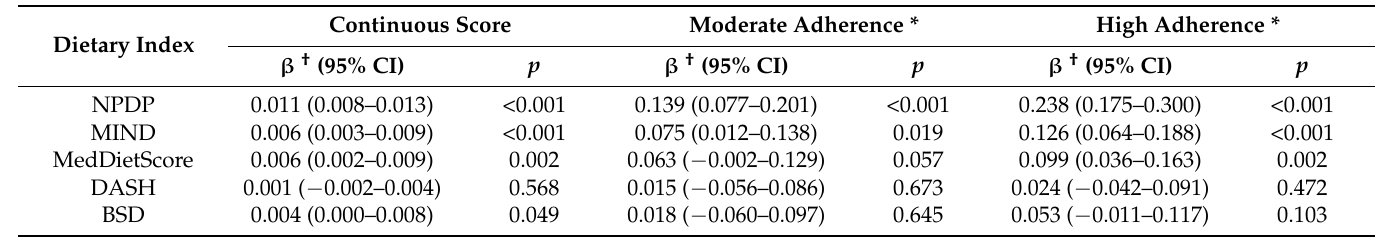
Table 3. β -coefficients (95% confidence intervals) for the association between the rate of change in MMSE score over 6 years and the Nordic Prudent Dietary Pattern (NPDP), Mediterranean-DASH Intervention for Neurodegenerative Delay (MIND), Mediterranean Diet Score (MedDietScore), Dietary Approaches to Stop Hypertension (DASH), and Baltic Sea Diet (BSD) indices